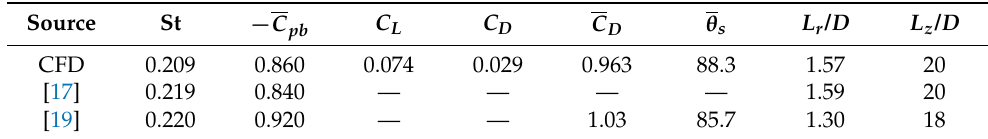
Table 2. Comparison of calculated data with available numerical and experimental results (for Re =